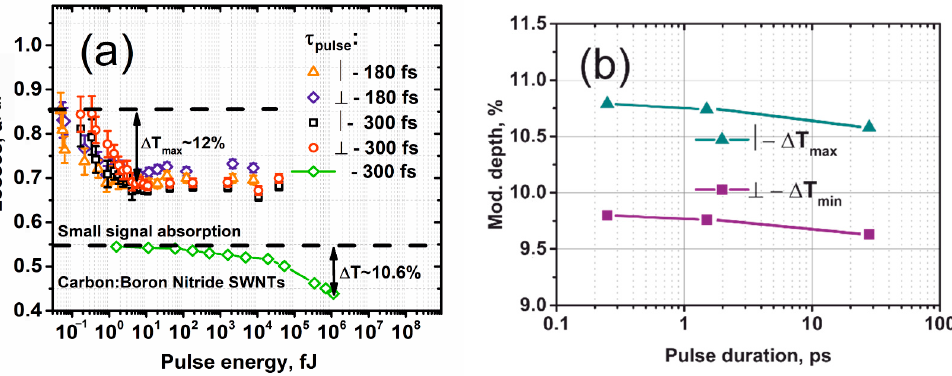
Figure 4. ( a ) Dependence of nonlinear optical losses of HDWA-SWCNTs and carbon nanotubes doped with boron and nitrogen using a homemade 300-fs USP source; ( b ) modulation depth Δ T of HDWA-SWCNTs vs. pulse width. Table 1. SWCNTs thin films parameters, along with the corresponding ML laser parameters.